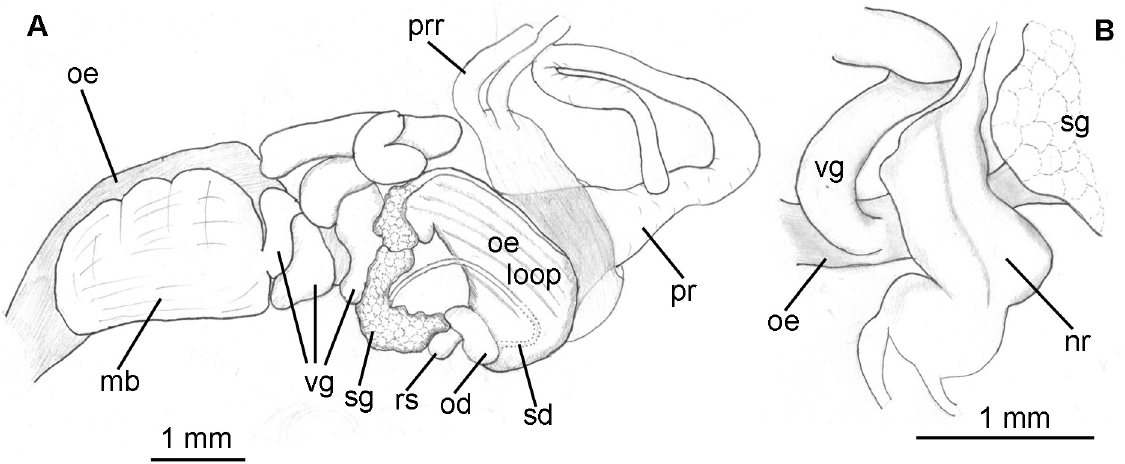
Fig. 5. Anterior foregut of Sibogasyrinx cf. pyramidalis (Schepman, 1913) 2, MNHN-IM-2009-16972. A . Right latero-dorsal view. B . Dorsal view of the nerve ring and opening of the venom gland. Abbreviations: mb = muscular bulb of the venom gland; nr = circumoesophageal nerve ring; od = odontophore; oe = oesophagus; pr = proboscis; prr = proboscis retractors; rs = radular sac; sd = salivary duct; sg = salivary gland; vg = venom